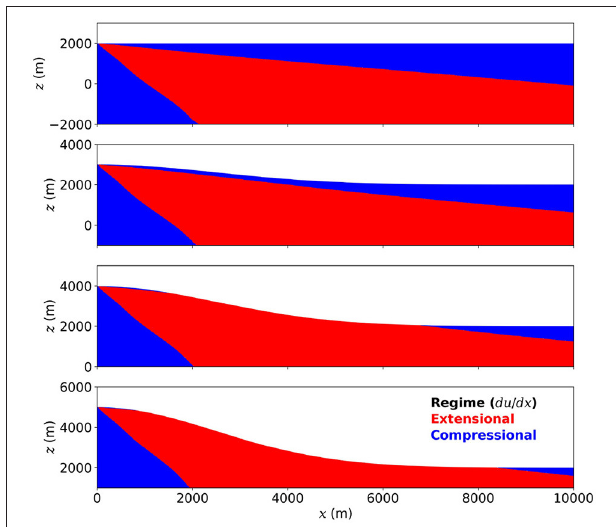
FIGURE 7 | du / dx , red where positive and horizontal displacement is increasing with increasing x , and so the horizontal distance between points is increasing (extension). Blue where negative, and the horizontal distance between points is decreasing (compression). Results are presented for edifices with heights between 2,000 and 5,000 m.